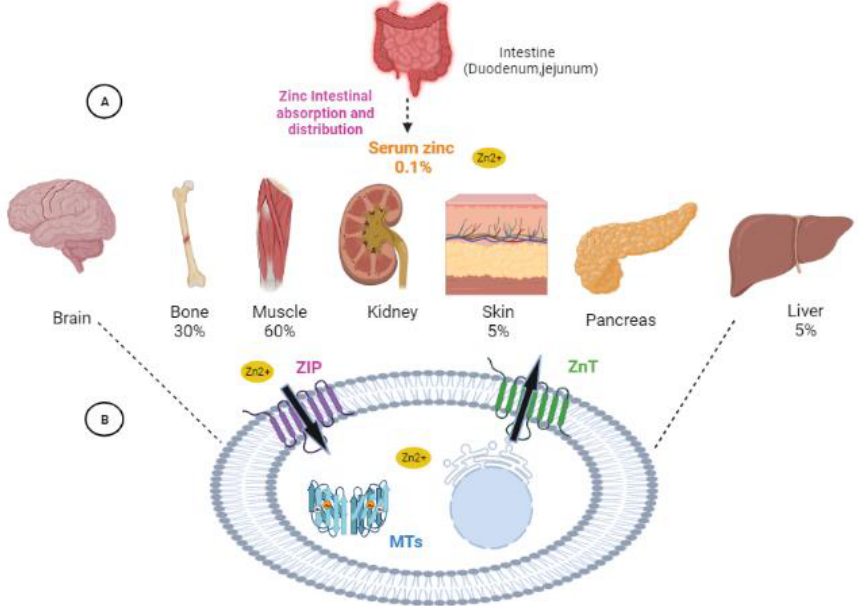
Figure 1. Zn homeostasis in the body and cellular mechanism. ( A ) Zn distribution in the body. ( B ) Cellular mechanism of Zn homeostasis: cellular Zn homeostasis is controlled by the cooperative function of MTs and two Zn transporter families (ZIP and ZnT). The arrows indicate the transmembrane pathways of Zn using ZIP and ZnT transporters.